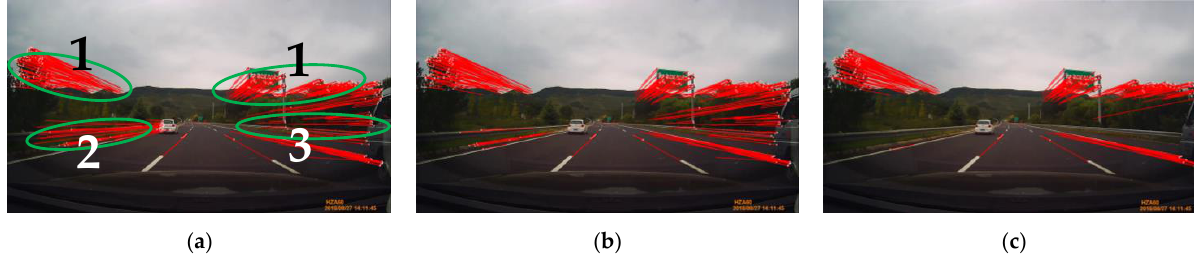
Figure 4. ( a ) Three types of motion vectors in a driving scene, where motion vectors types 1, 2, and 3 come from the stationary background, accelerating, and decelerating vehicles, respectively. The motion vectors ( b ) when applying motion vector type 2 reduction sub-step and ( c ) when applying both motion vector type 2 and 3 reduction sub-steps.